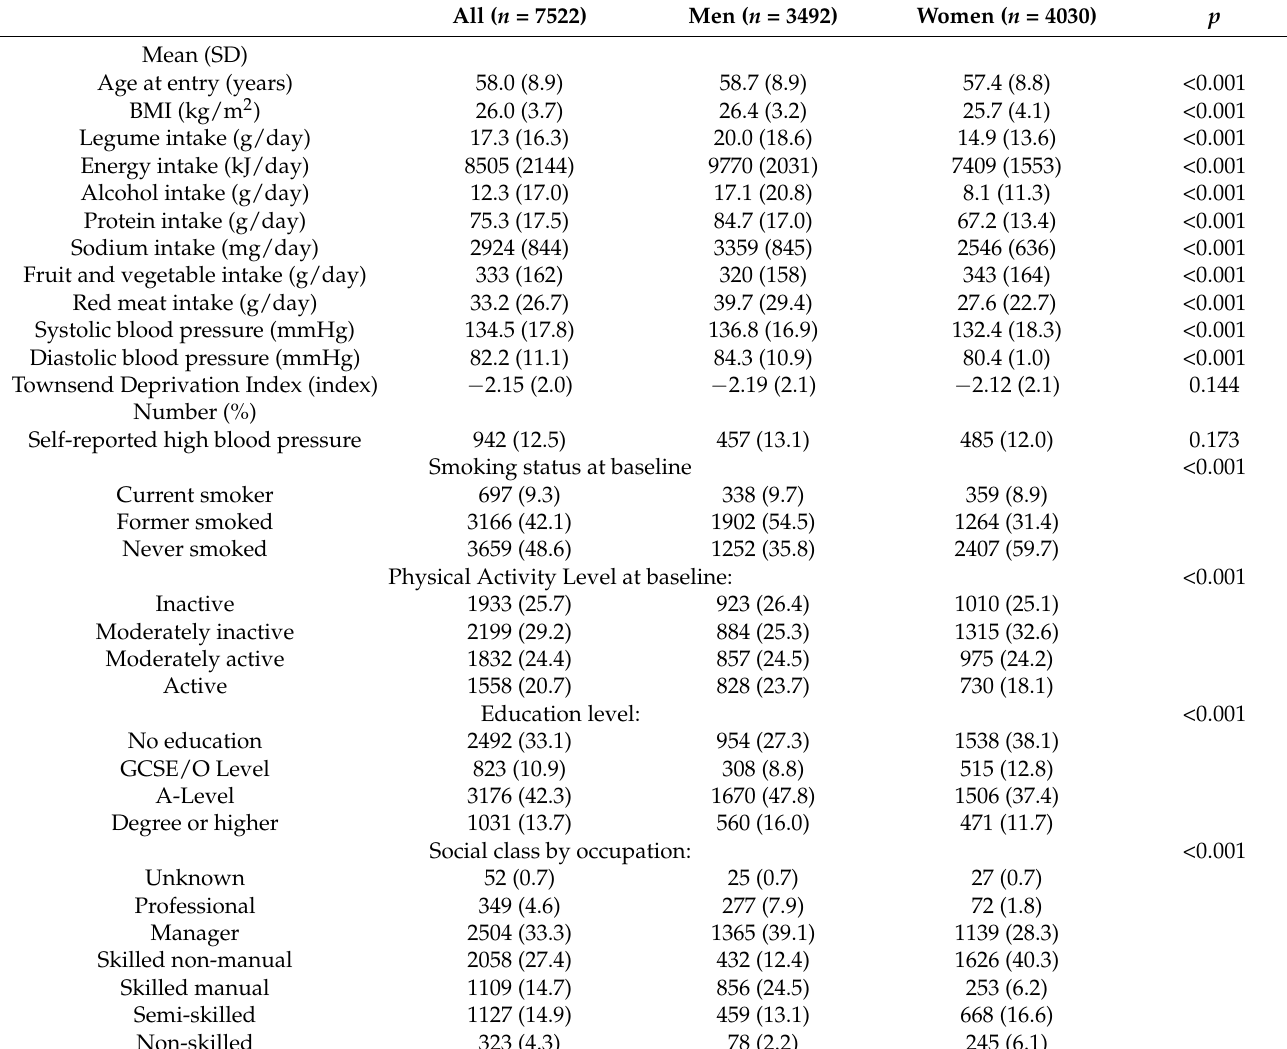
Table 1. Mean ( ± SD) overall and sex-specific sample characteristics of 7522 participants